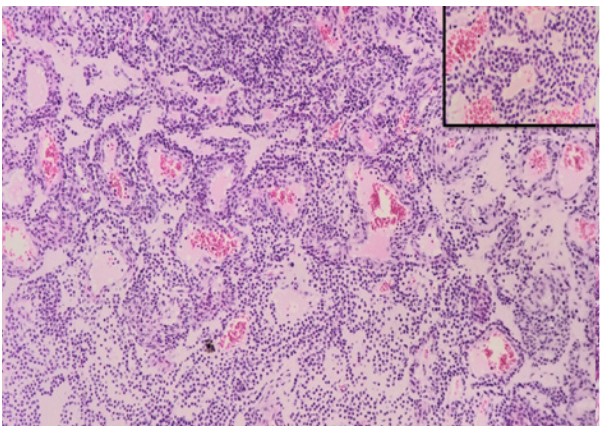
Figure 4: Basal cell carcinoma. The islands of tumor cells show peripheral palisading and retraction artefact (HE stain; X40).